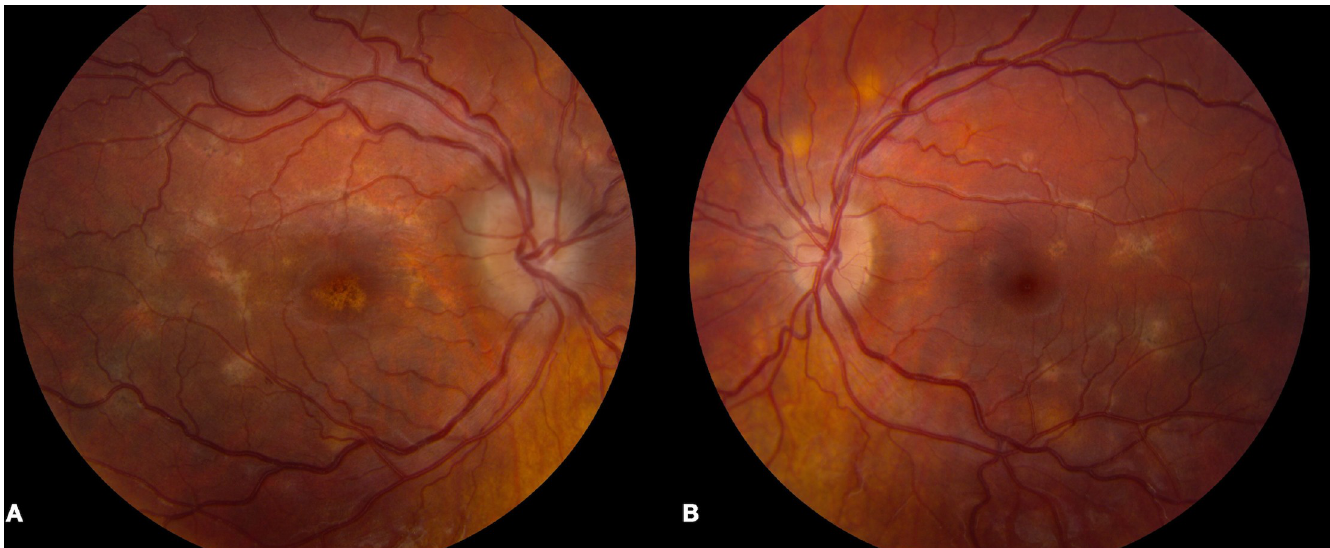
Fig 2. Bilateral disc edema and characteristic fundus findings in patient 4. Fundus photos of patient 4 demonstrated bilateral disc edema and multiple cream-colored lesions in the posterior pole of the right (A) and left (B) eyes.